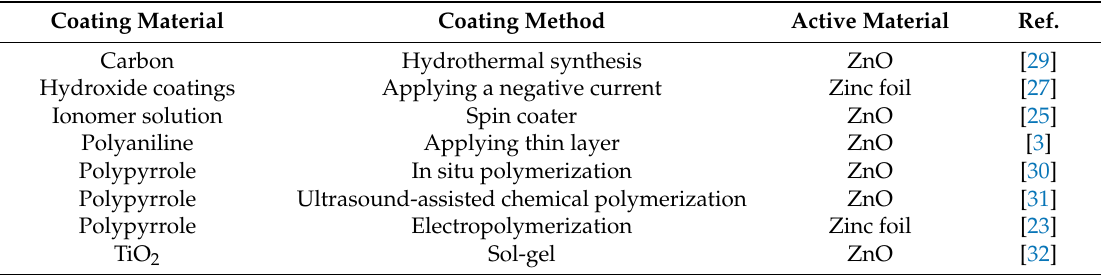
Table 1. List * of some of the reported state-of-the-art coating materials and methods investigated for secondary zinc electrode